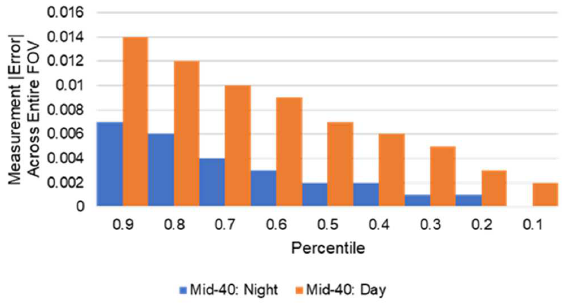
Figure 38. Amount of error observed in Livox ® Mid–40 measurements in night and day scan conditions, by percentile.